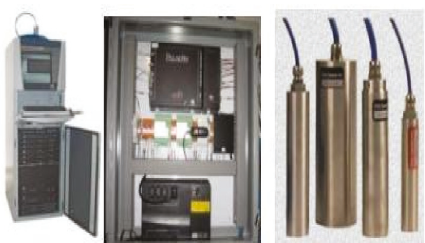
Figure 2: Mainframe processing system, substations, and sensors of the microseismic monitoring